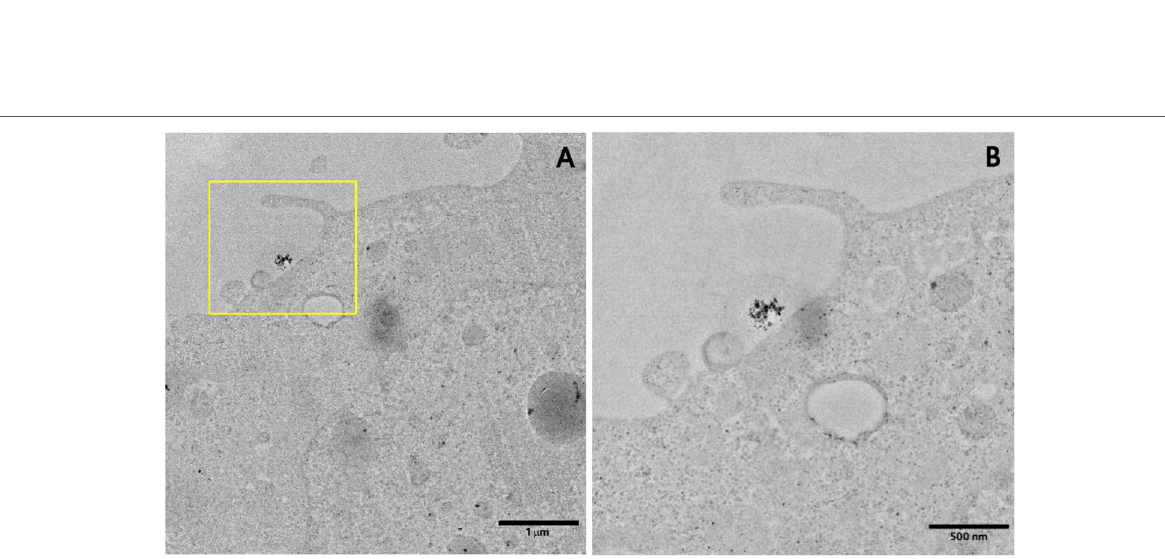
Fig. 7 PET‑NPs engulfment by cells. TEM micrograph of macrophage and its response to PET nanoparticles at 24 h. Image showed a cell membrane elongation ( A ) that is wrapping a PET nanoparticles conglomerate ( B